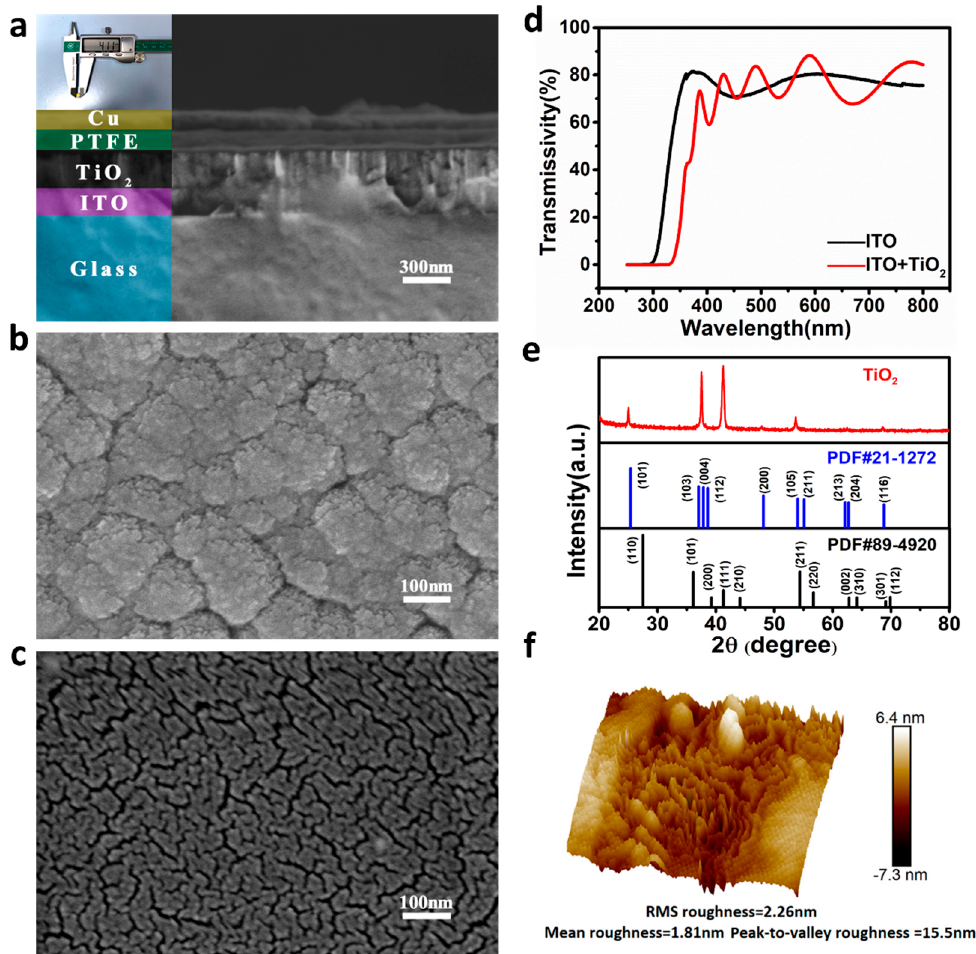
Figure 2. Material characterization. ( a ) Cross-sectional scanning electron microscopy (SEM) images of ITO/TiO 2 /PTFE/Cu film and photograph of the IEFB-SP photodetector. SEM images of TiO 2 ( b ) and PTFE ( c ) surfaces. ( d ) Optical transmission spectra of the ITO with glass substrate and the sample after the growth of TiO 2 film. ( e ) X-ray diffraction (XRD) pattern of the TiO 2 film. ( f ) AFM image of the TiO 2 surface.